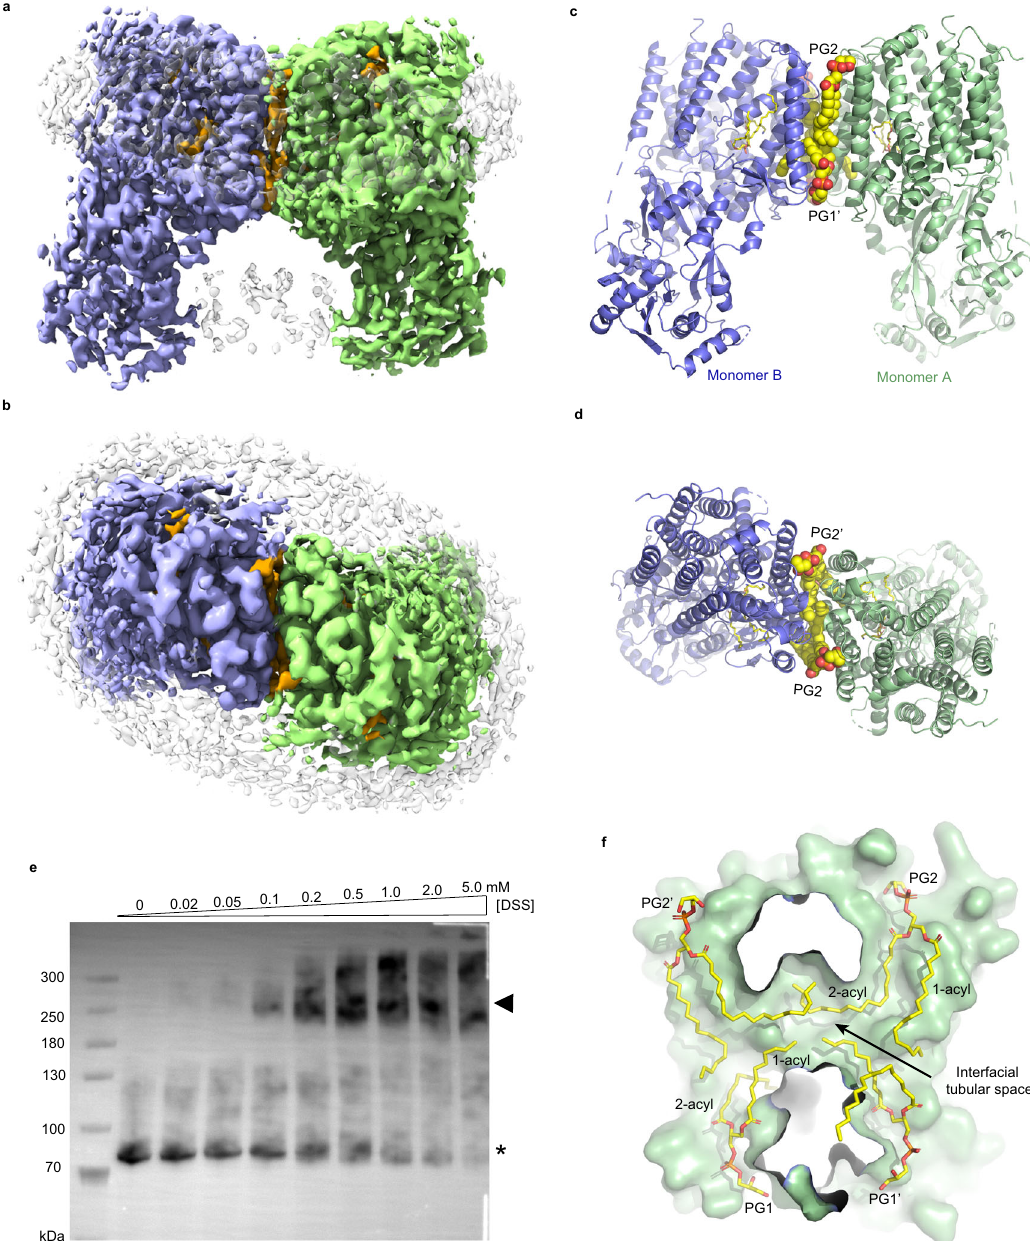
Fig. 1 Overall structure of Rt MprF(DDM)-nanodic homodimer at 3.7-Å resolution. Cryo-EM densities of Rt MprF dimer embedded in a nanodisc viewed along membrane plane ( a ) and along membrane normal from periplasmic side ( b ). Color codes: light green and light blue, two adjacent monomers of Rt MprF dimer; yellow, lipid molecules; gray, nanodisc scaffold, uninterpreted lipid and other densities from adjacent Rt MprF dimer. Cartoon models of Rt MprF dimer viewed along membrane plane ( c ) and along membrane normal from periplasmic side ( d ). The four phospholipid molecules at the dimer interface are highlighted as sphere models and the LysPG inside monomers are shown as stick models. PG phosphatidylglycerol. e Western blot of the crosslinked products of Rt MprF protein in the membrane. The asterisk indicates the position of Rt MprF monomer, while the arrowhead labels the position of Rt MprF dimer. DSS was used for the crosslinking experiment. The experiment was repeated independently three times with similar results. f The interfacial tubular void space at the dimer interface accommodating the four acyl chains from the PG molecules. The sectional view of the surface model of monomer A is shown and monomer B is omitted for clarity. PG molecules are shown as stick